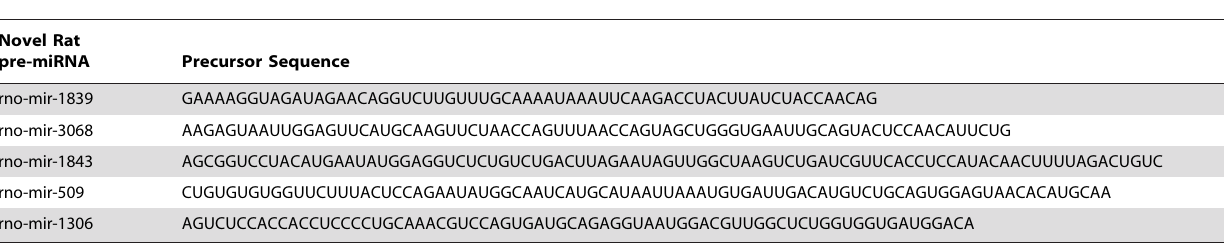
Table 4. Five novel rat homologous pre-miRNAs